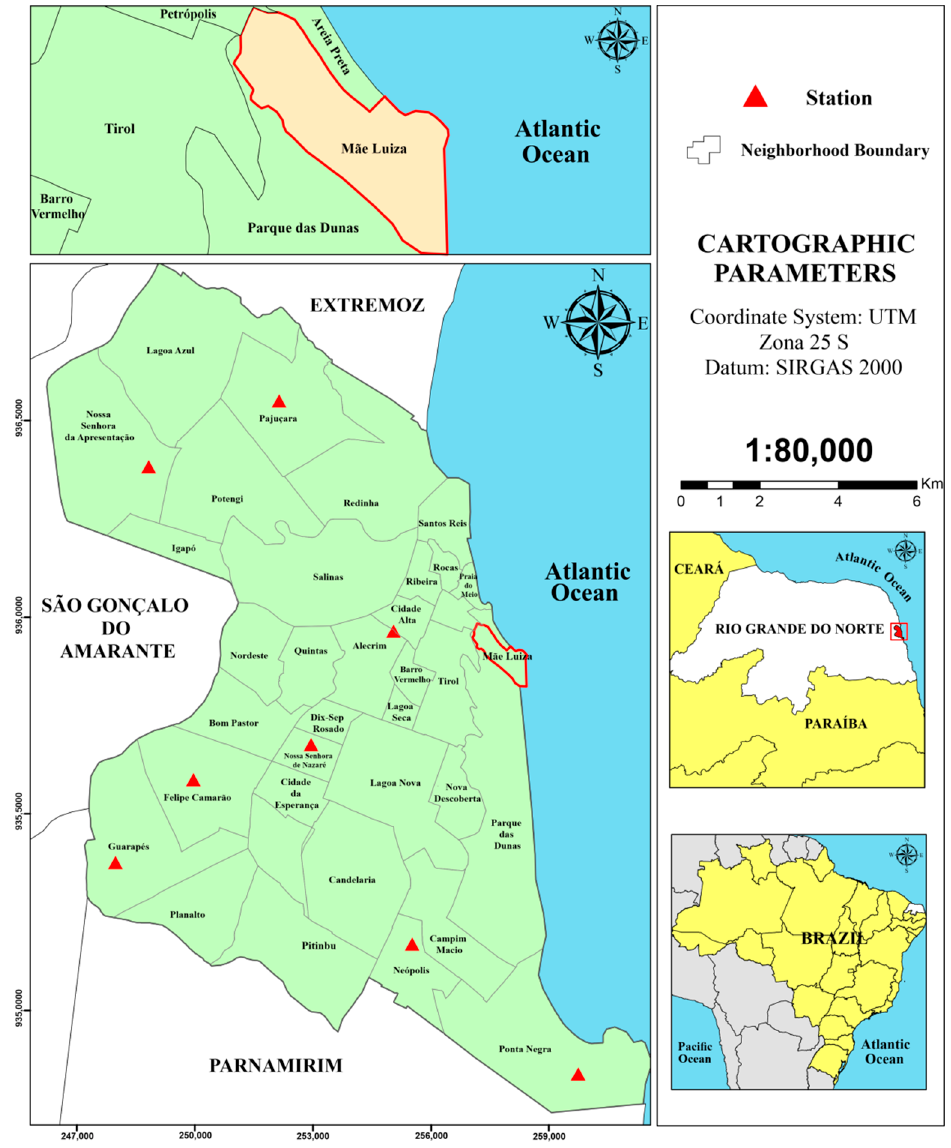
Figure 1. Location of the district of Mãe Luiza, situated in the Eastern Zone of Natal. The precipitation regime for the region, in addition to being related to its proximity to the ocean, is influenced by atmospheric systems, among which Easterly Wave Disturb- ances (EWDs) stand out. These systems are responsible for high amounts of rainfall along the coast the Northeast region of Brazil. These are atmospheric disturbances observed in the tropics, in the area of influence of the trade winds, moving from east to west, that is,